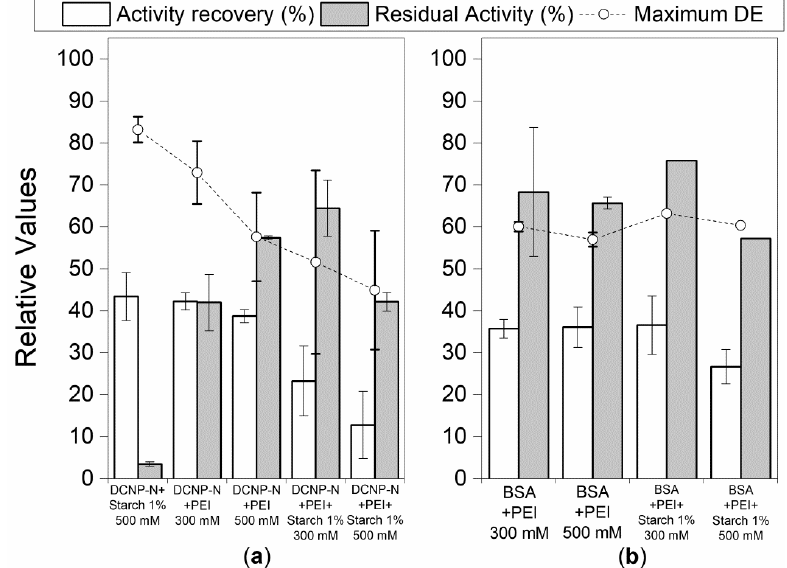
Figure 11. Recovered activity and performance of CLEAs of amyloglucosidase (AMG) in the hydrolysis of 3% ( w / v ) starch (Dextrose Equivalent and residual activity). CLEAs were prepared by co-aggregation with the magnetic nanoparticles DCNP-N or bovine serum albumin (BSA) in the presence of 1% ( w / v ) starch or polyethyleneimine (PEI) or both. A volume of 20 mL of starch (3%, w / v ) solution was hydrolyzed by 20 U of AMG CLEAs at 55 °C and pH 4.5 for 6 h under 300 rpm stirring. Values are shown as the mean of duplicate experiments ± s.d.